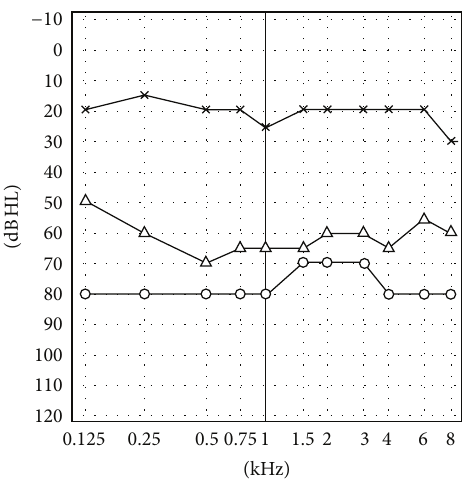
Figure 4: Pure tone audiogram before (open triangle) and 4 weeks after intratympanic gentamicin treatment (open circle) in right- sided M´eni`ere’s disease, unaffected left side